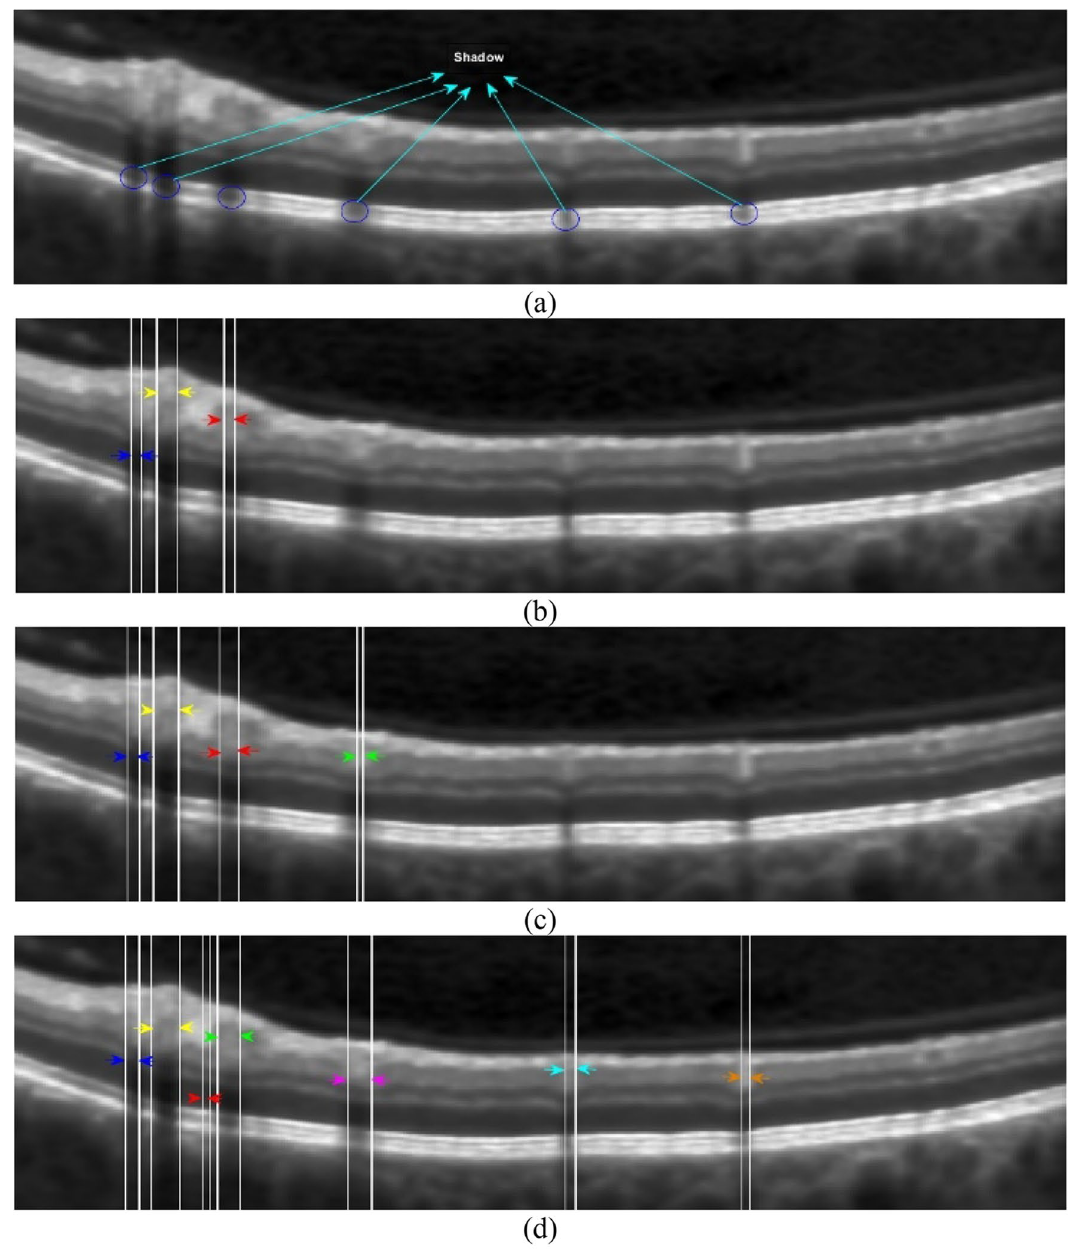
Figure 4. ( a ) An OCT image containing shadow columns, shadow columns extracted by the pseudo-code of Algorithm. 2 for ( b ) α = 0.16, ( c ) α = 0.12, ( d ) α = Post-processing. In this section, the superfluous pixels which are mistakenly extracted as the boundary pixels for cysts in the previous phase are removed. It should be mentioned that the existence of shadows in OCT images leads to have dark regions. The boundary pixels for such dark regions may be falsely considered as the boundary pixels for cysts. Therefore, if these points are not correctly identified and removed, the OCT image may be falsely interpreted as cystic. Thus, in this section a new algorithm is proposed for detecting shadow col- umns in the OCT image. A sample OCT image which includes shadow columns is presented in Fig. 4a. Before explaining the new algorithm for shadow detection and the third phase of CIBICA algorithm, we notice to shadow regions in Fig. 4a to extract their distinguishing features. As can be observed in Fig. 4a, the shadow region is a set of consecutive dark columns. In fact, in the shadow regions, no significant vertical intensity change is observed after ONL + ISL layer boundary. This is while in the columns not including shadows, a significant intensity change is observed specially in the starting pixels of ONL + ISL layer or before RPE layer boundaries. This can be considered as a distinguishing feature between the columns including and not including shadow .